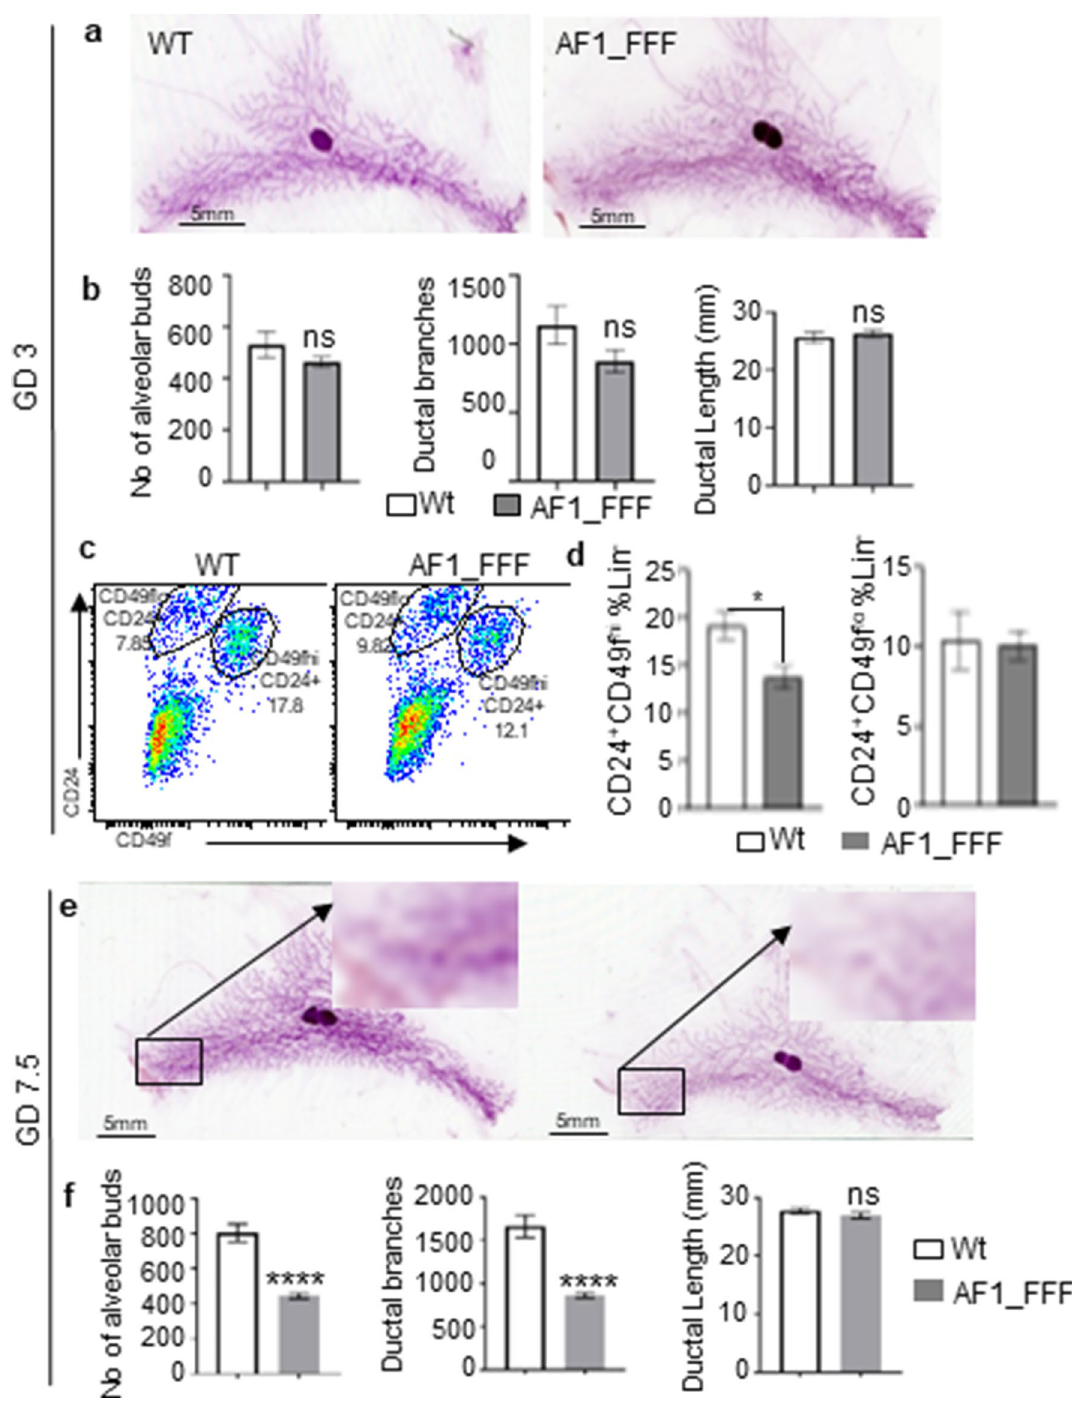
Figure 3. AF1_FFF mutations lead to reduced mammary growth during pregnancy. ( a , b ) Mammary development on GD 3 is similar between the WT and AF1_FFF mice. ( a ) Representative whole mount images on GD3; ( b ) quantitative data of alveolar buds, ductal branching and ductal length (n = 7 for WT, n = 8 for AF1_FFF, ns , not significant). ( c , d ) Significant less MaSC (Lin − CD49f hi CD24 + ) in AF1_FFF mice on GD3 (*p < 0.05). ( c ) FACS dot blots showing Lin − CD24 + CD49f lo and Lin − CD24 + CD49f hi cell gating. ( d ) Percentage of Lin − CD24 + CD49f lo and Lin − CD24 + CD49f hi cells relative to Lin − cell populations (WT, n = 4; AF1_FFF, n = 4, *p < 0.05). ( e , f ) Mammary development on GD7.5 in AF1_FFF mice is significantly impaired. ( e ) Representative whole mount images; ( f ) quantitative data of the alveolar buds, ductal branching and ductal length (WT, n = 10; AF1_FFF, n = 11, ****p < 0.001). All numeric data are expressed as mean ±